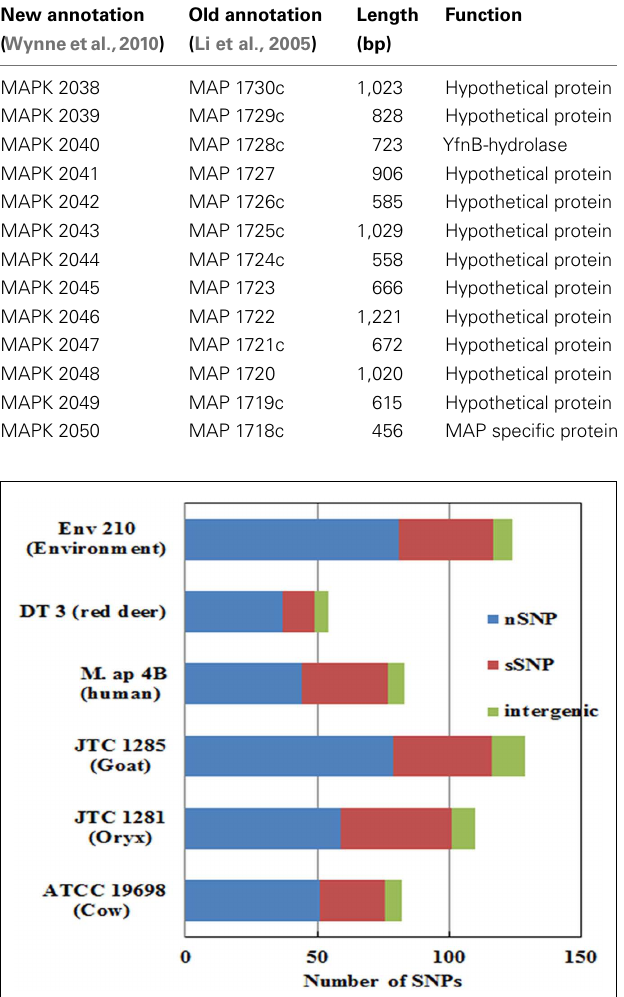
FIGURE 4 |The total number of single nucleotide polymorphism (SNP) among M. ap isolates. The number of nSNP (non-synonymous) and sSNP (synonymous) and SNPs in the intergenic regions are color coded as indicated. SNPs were detected using reference assembled sequences of each strain. About 60–130 SNPs were detected M. ap isolates. Percentage of nSNP is generally higher than sSNP which indicates a high selective pressure in these